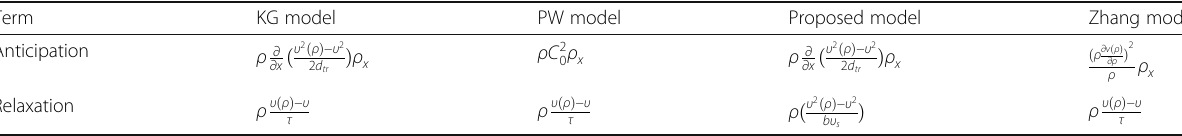
Table 1 Traffic model comparison Term KG model PW model Proposed model Zhang